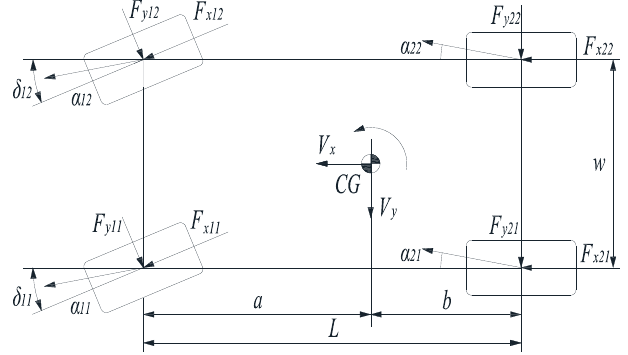
Figure 1. The non-linear three-degrees-of-freedom (3-DOF) vehicle model. The equation of the longitudinal motion is: